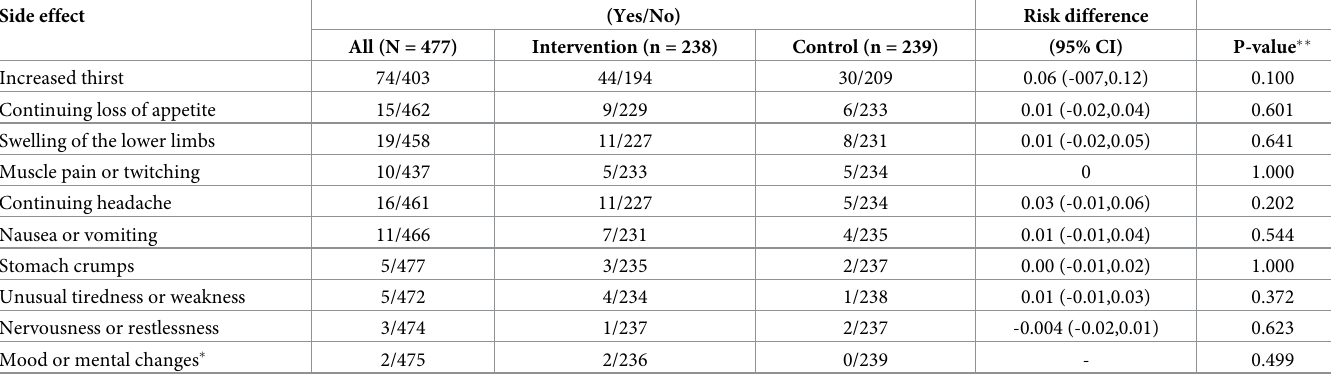
Table 4. Side effects of sodium bicarbonate infusion among women with obstructed